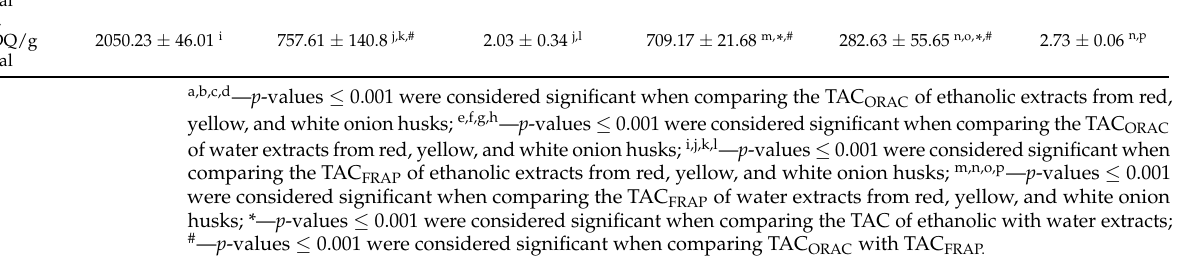
Table 2. TAC of onion husk extracts determined using the FRAP and ORAC methods. Ethanol Water Red Yellow White Red Yellow White TAC ORAC , µ mol-equiv.